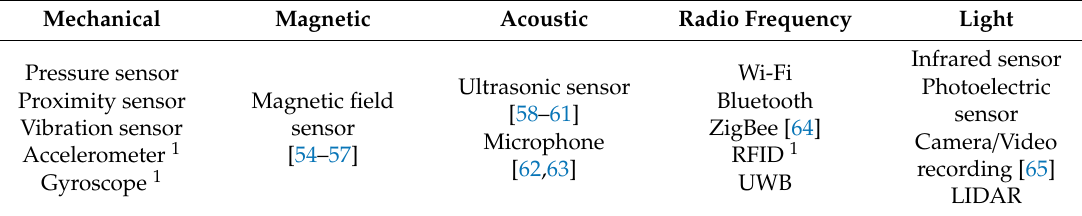
Table 3. Classification of indoor tracking and localization